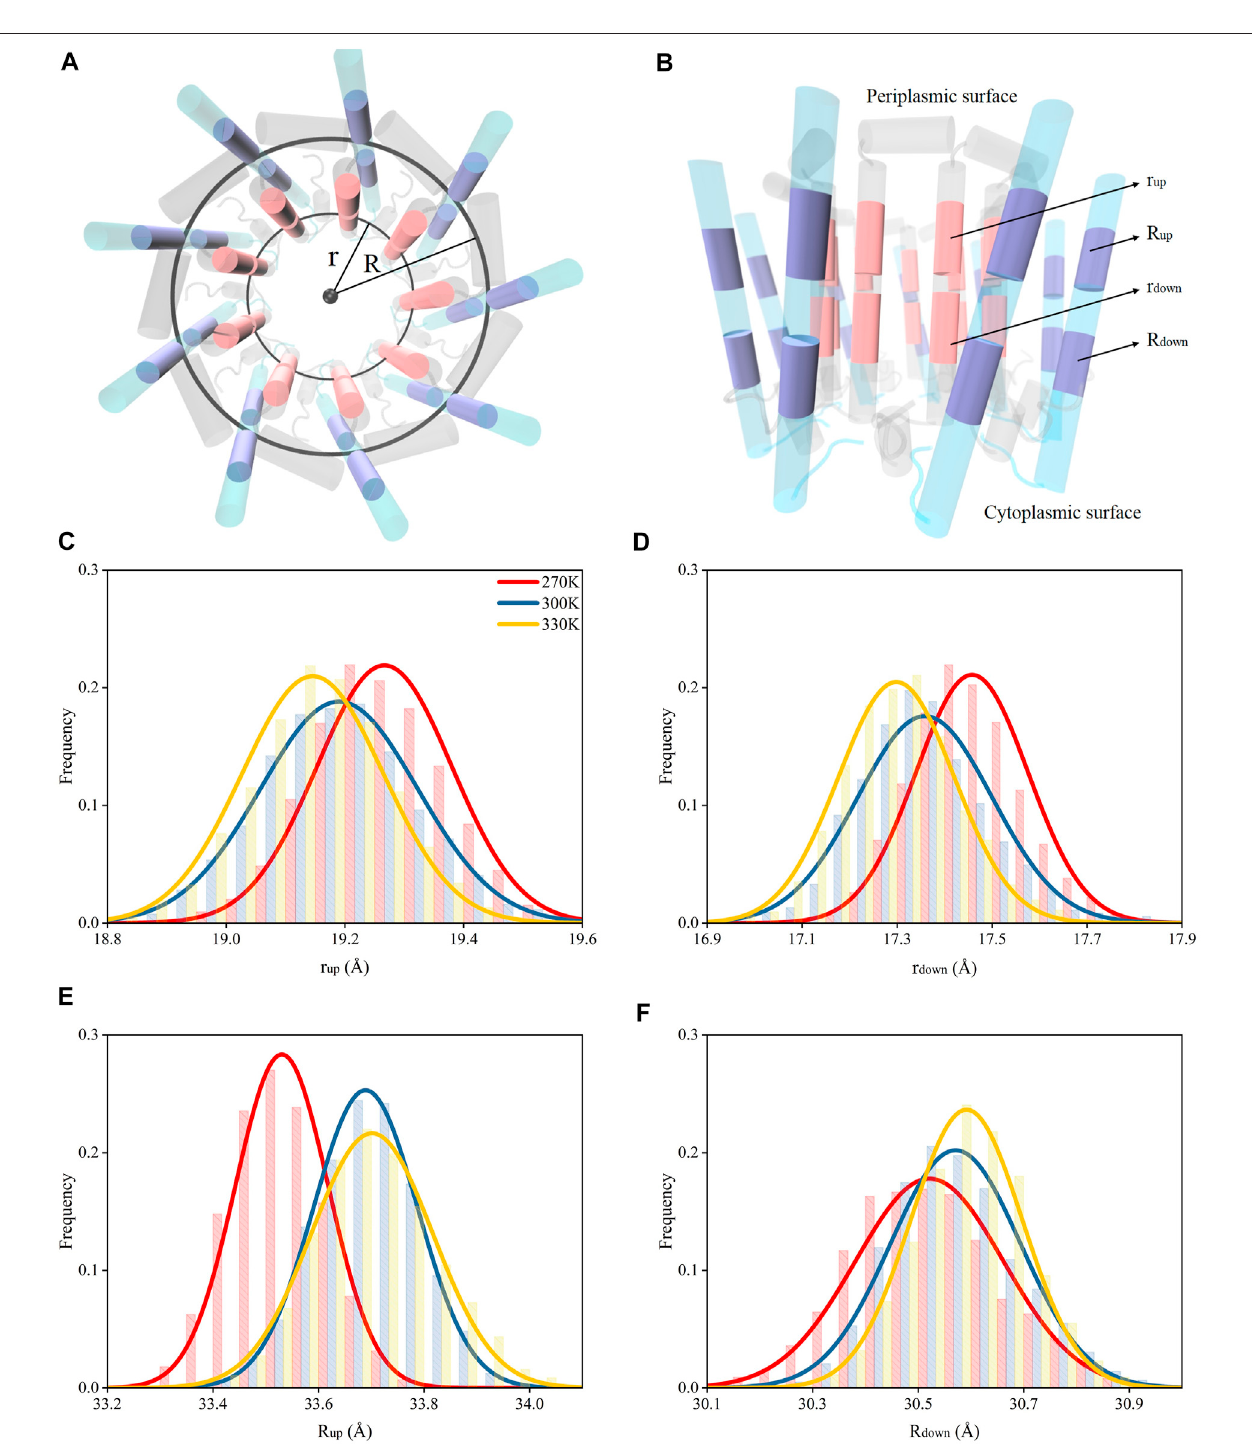
FIGURE4| Radiifortheringsformedbythepolypeptidehelicesunderdifferenttemperatures. (A) Topviewofcirculararrangementsof α (inner)and β (outer)helices in LH2. Radii for α and β polypeptide helices were noted as “ r ” and “ R ” , respectively. (B) Side view of α and β polypeptide helices. The circles fi t by the mass centers of 26th – 32nd (closer to periplasmic surface, colored in pink) and 17th – 23rd residues (closer to cytoplasmic surface, colored in pink) in 9 α helices are noted as “ r up ” and “ r ” , respectively. The circles fi t by the mass centers of 77th – 82nd (closer to periplasmic surface, colored in purple) and 66th – 71st residues (closer to down cytoplasmic surface, colored in purple) in 9 β helices are noted as “ R up ” and “ R down ” , respectively. Distributions of r up (C) , r down (D) , R up (E) , R down (F) under different temperatures.